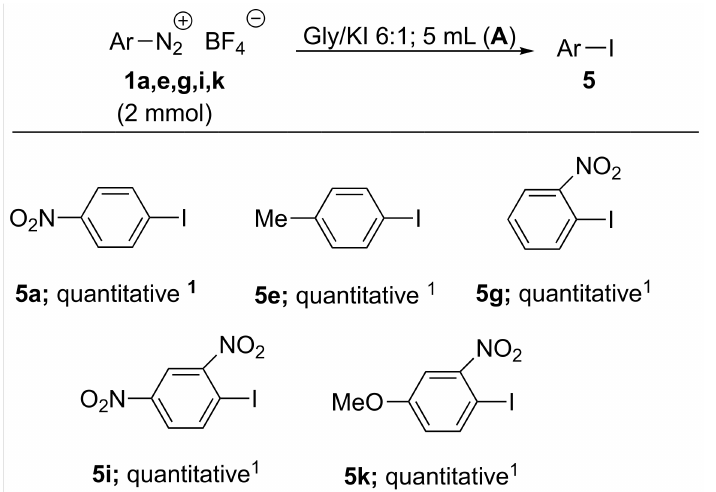
Figure 3. Iododediazotation scope. 1 Reactions were carried out at room temperature for 2 h: 2 mmol of salts 1 and 5 mL of Gly/KI. Yields refer to pure and isolated 5